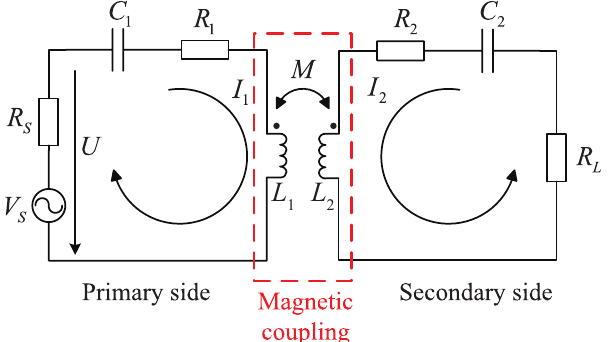
Figure 1. Equivalent circuit topology of WPT system with SS compensation